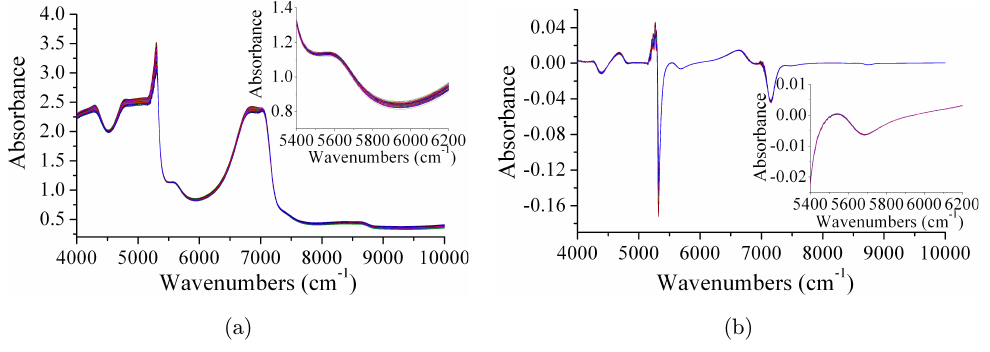
Fig. 3. Raw NIR spectra (a) and ¯rst derivative spectra smoothed by Savitzky – Golay ¯lter